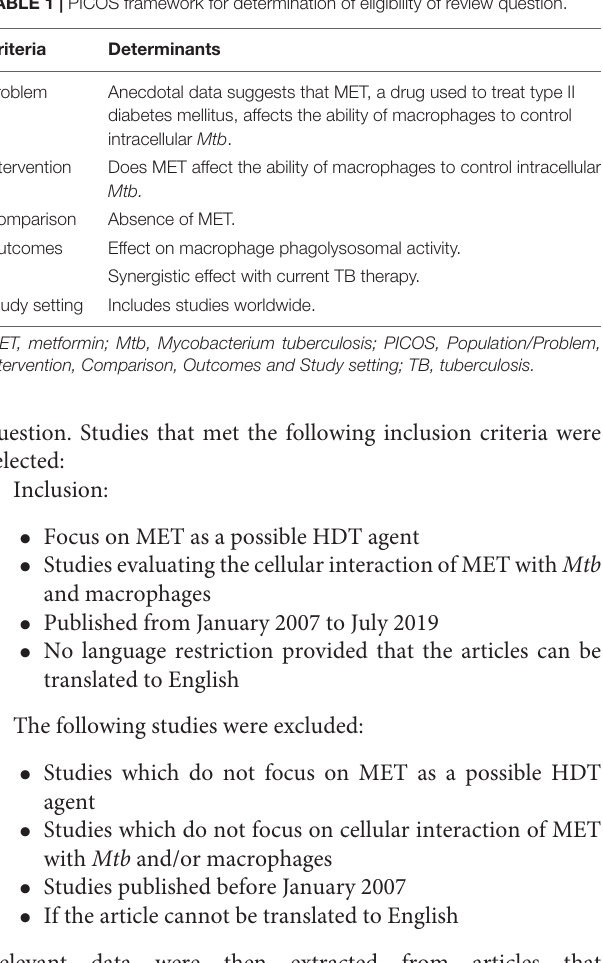
TABLE 1 | PICOS framework for determination of eligibility of review